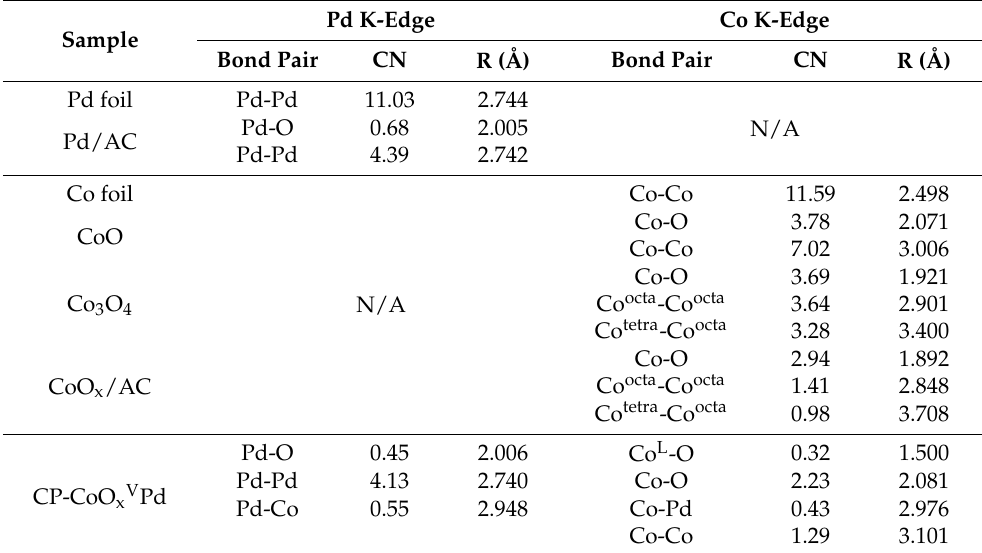
Table 1. Quantitative results of X-ray absorption spectroscopy model analysis at Co and Pd K-edges of experimental and reference